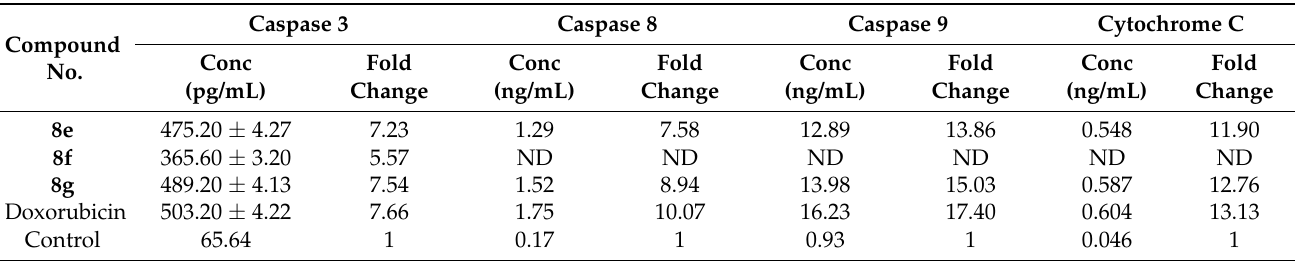
Table 4. Effects of compounds 8e , 8f , 8g , and doxorubicin on active Caspases 3, 8, 9, and cytochrome C in MCF-7 breast cancer cell line.